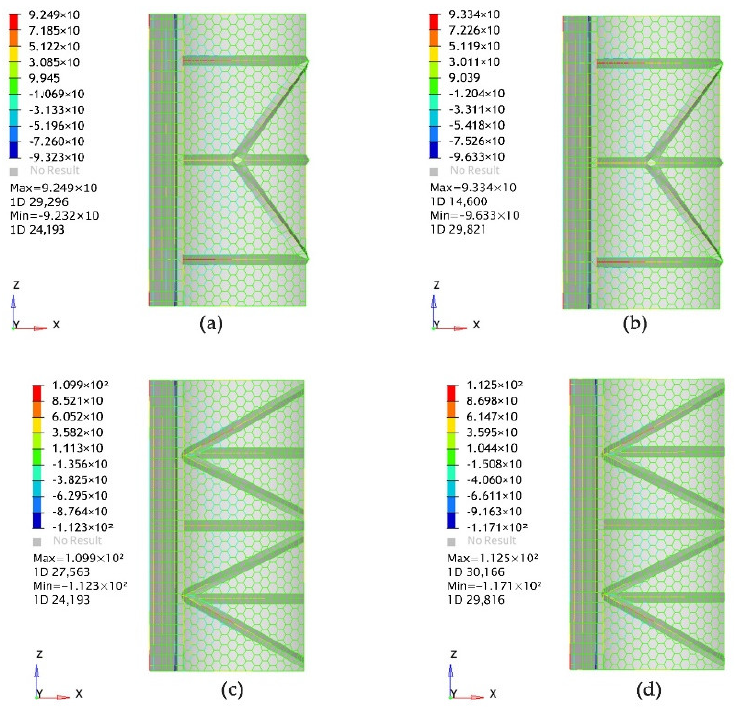
Figure 23. ( a ) Linear stress analysis of the carport I model under the G k + 0.85 Q S + Q W load; ( b ) Nonlinear stress analysis of the carport I model under the G k + 0.85 Q S + Q W load; ( c ) Linear stress analysis of the carport II model under the G k + 0.85 Q S + Q W load; ( d ) Nonlinear stress analysis of the carport II model under the G k + 0.85 Q S + Q W load.